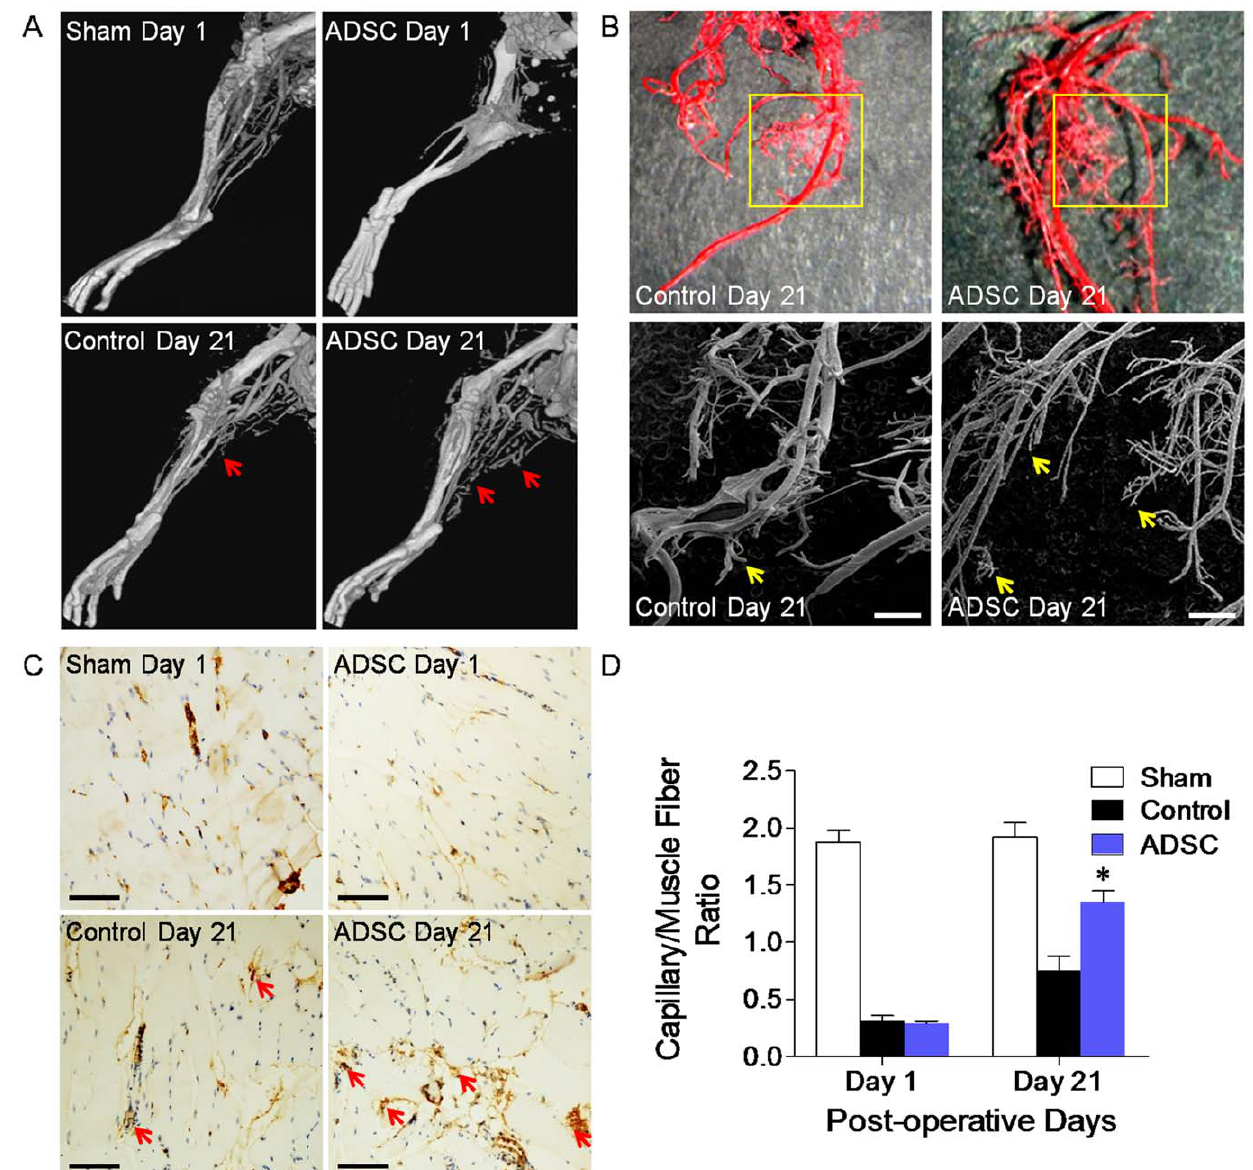
Figure 5. Transplanted mADSCs promoted collaterals formation and angiogenesis invivo . Micro-CT angiography showed that mADSCs significantly increased collateral vessels formation (red arrows) on day 21 ( a ). Vascular cast (upper panels) and scanning electron microscopy (lower panels) visualized 3D architecture of microvasculature and demonstrated the enhanced angiogenesis (yellow squares and arrows) in ADSC-treated animals compared to control group animals on day 21 ( b ). Immunohistochemical staining ( c ) and quantitative analysis ( d ) displayed higher CD31- positive capillary (red arrows) to muscle fiber ratio in the ADSC group compared to the control group on day 21. n=20 random fields. Scale bar represents 10 m m (b), 100 m m (c). Error bars: mean 6 SD. * P , 0.01 vs.